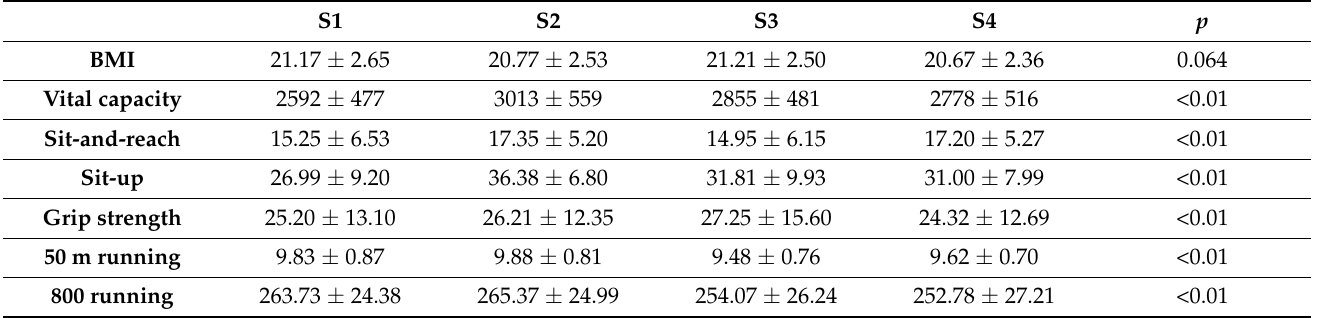
Table 5. The results of Kruskal–Wallis test: the difference in physical fitness of female students. S1 S2 S3 S4